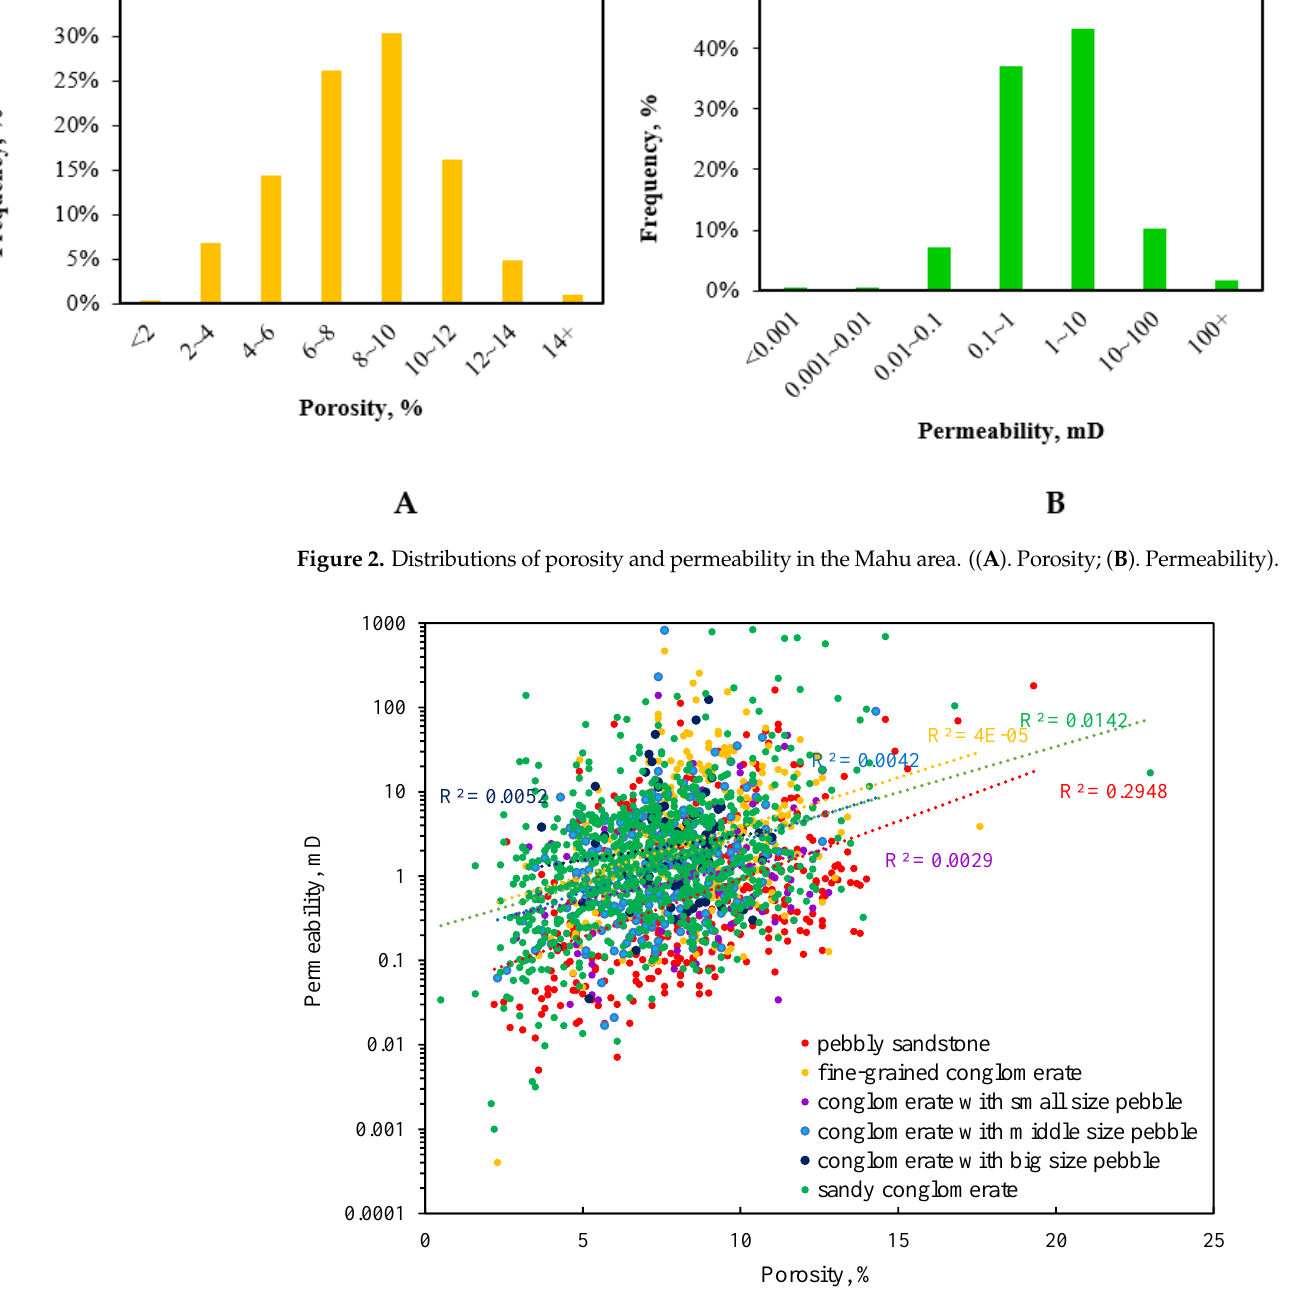
Figure 3. Correlation between porosity and permeability for the different conglomeratic lithologies in the Mahu area.